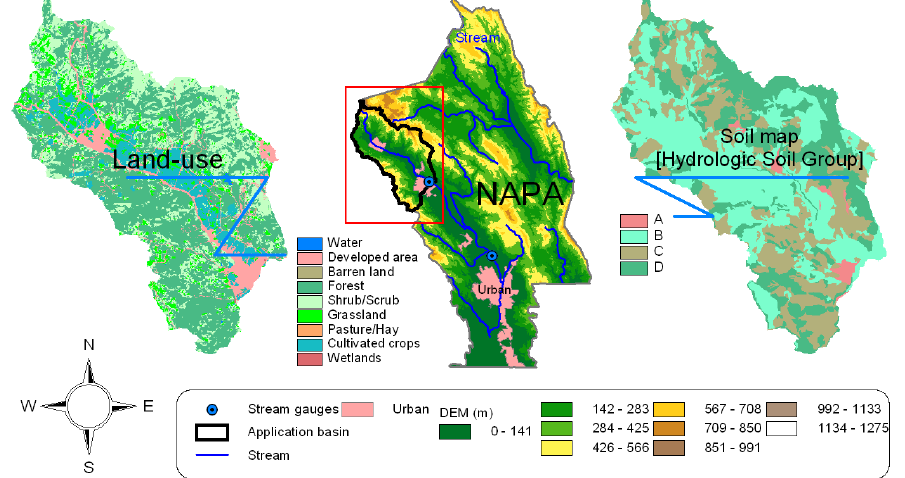
Figure 3. Land-use map ( left ), digital elevation with the watershed location ( middle ), and soil map ( right ) for the application watershed, St. Helena area, Napa County, California.